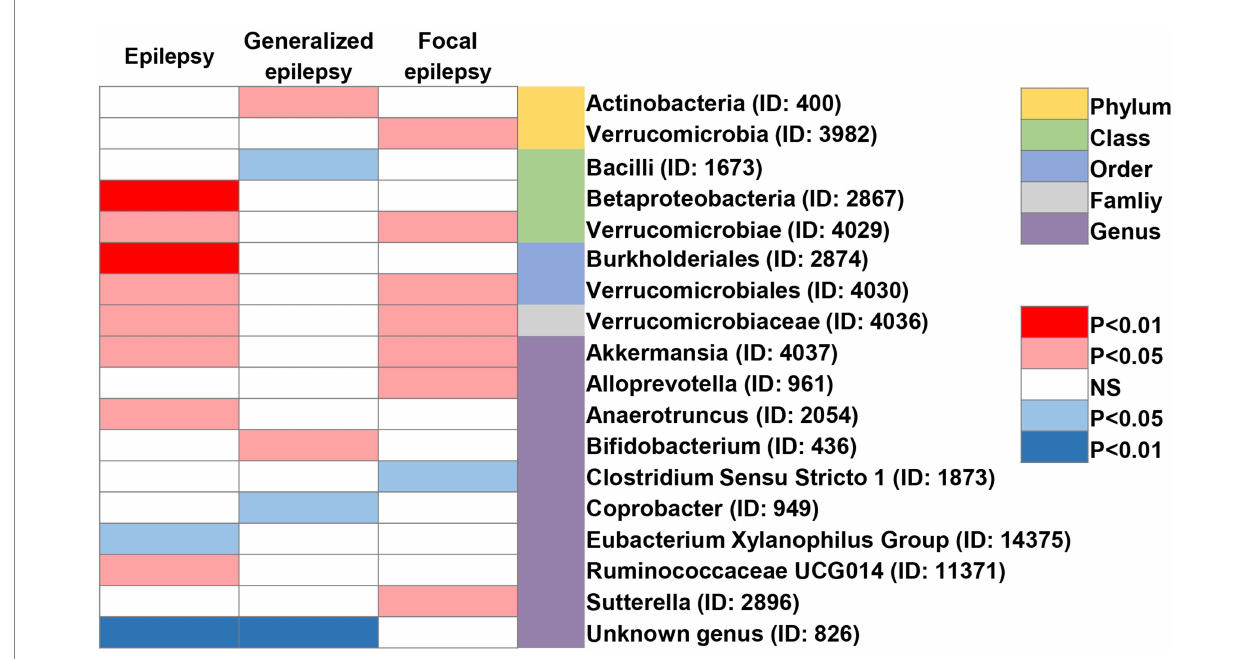
FIGURE 6 Heat map of GM taxa causally associated with epilepsy, generalized epilepsy, and focal epilepsy identified by IVW method. Red represents risk factors, while blue represents protective factors.